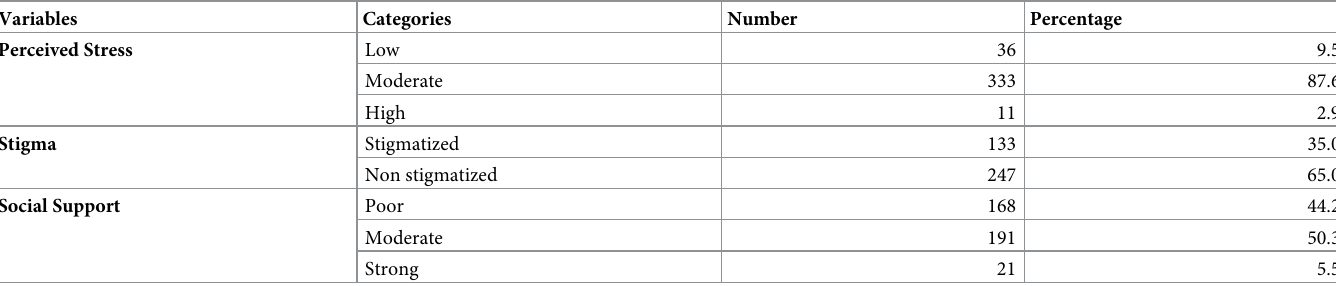
Table 3. Level of perceived stress, stigma, and social support.